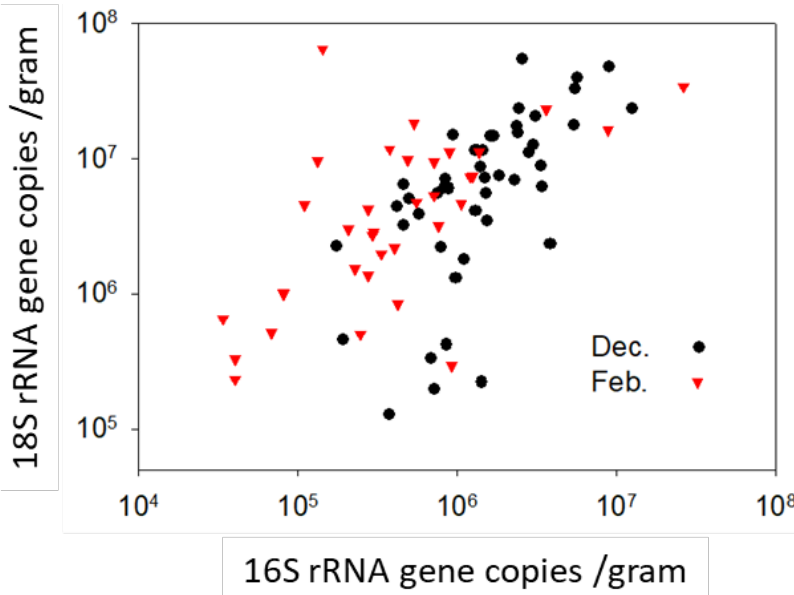
Figure 6. Data from Figure 5 illustrating the strong relationship between fungi and bacteria in stored pollen. The abundance of fungi (18S rDNA) and bacteria (16S rDNA) were significantly and positively correlated based on log-transformed estimates of abundance (R 2 = 0.25, F 2,72 = 24.2, p < 0.0001).